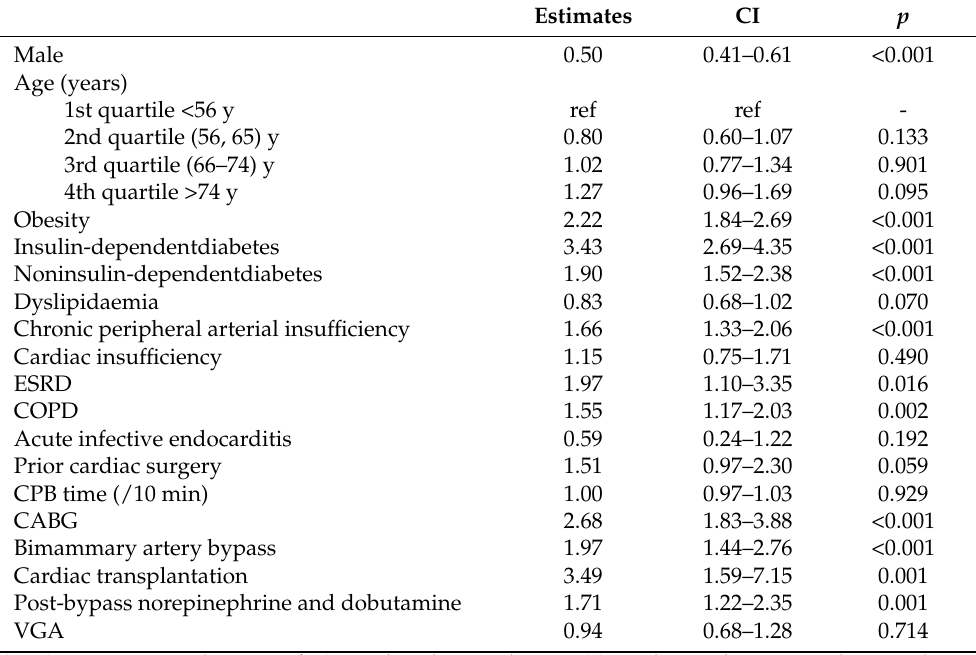
Table 2. Multivariate analysis of risk factors for SSI.